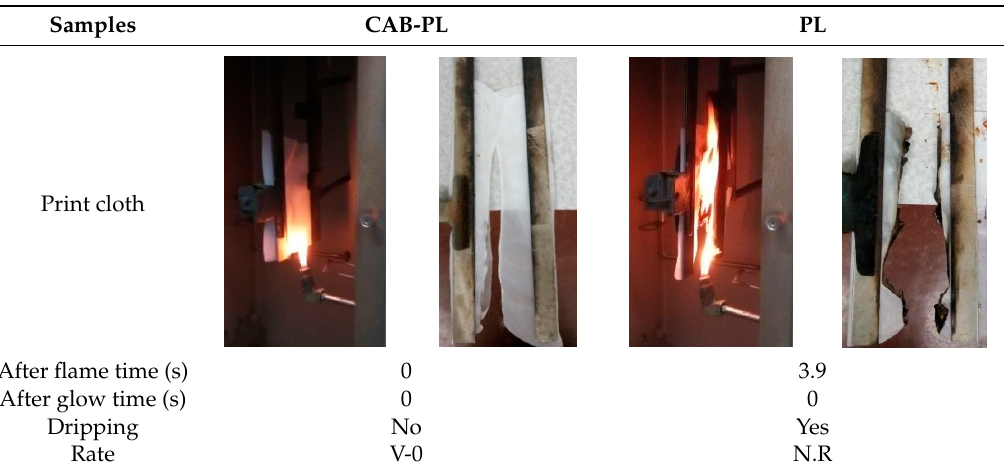
Table 2. Results of UL-94 for CAB-PL and PL.